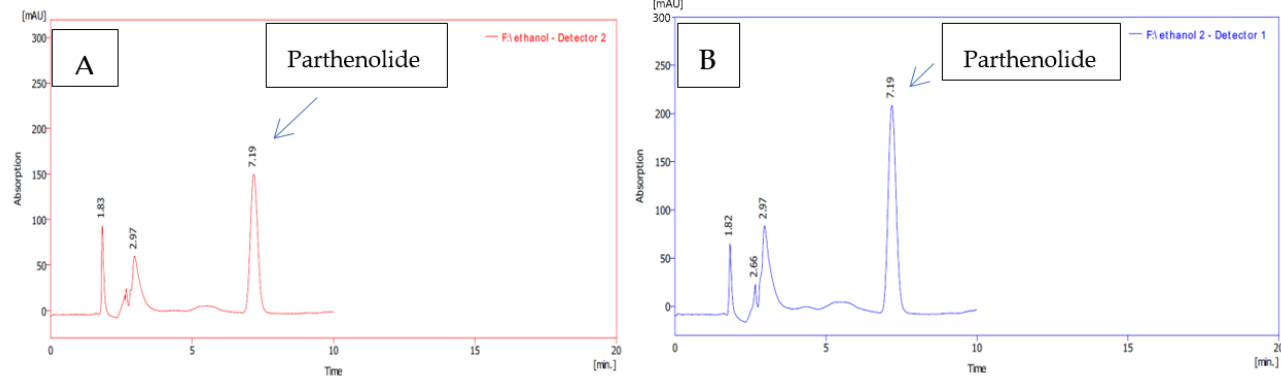
Figure 2. HPLC analysis of ethanolic extracts of ( A ) micropropagated ( B ) conventionally propagated feverfew plants’ leaves.